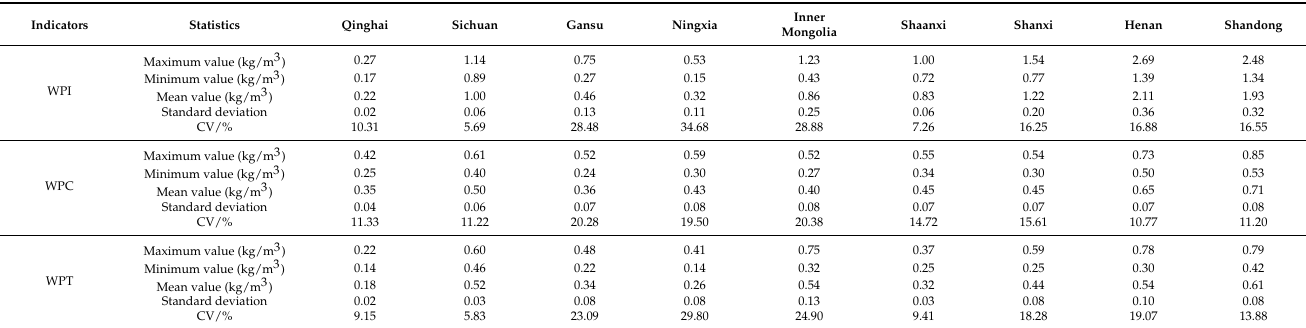
Table 2. The statistical characteristics of water productivity in the Yellow River Basin from 2000 to